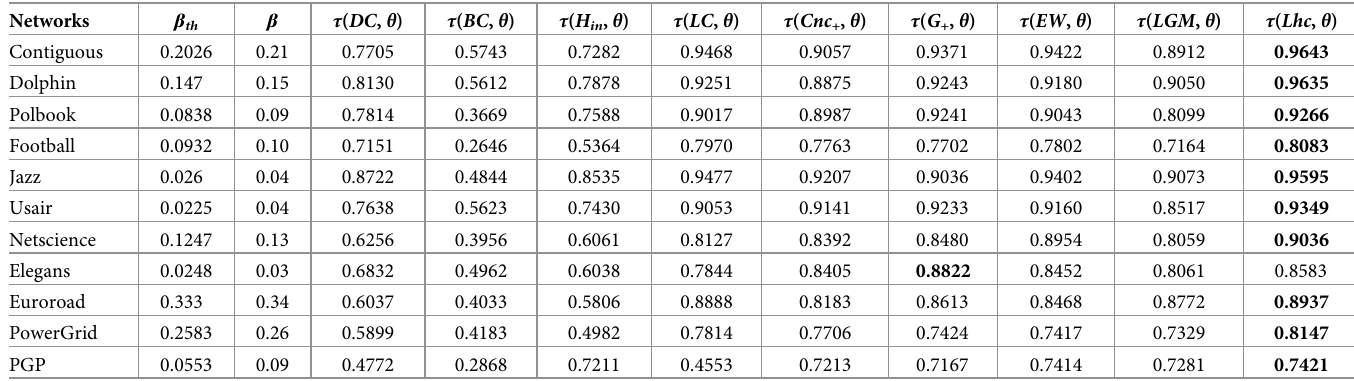
Table 2. The kendall’s tau( τ )values between the ranking list obtained from the nine measures and the list offered by the SIR model on eleven networks.